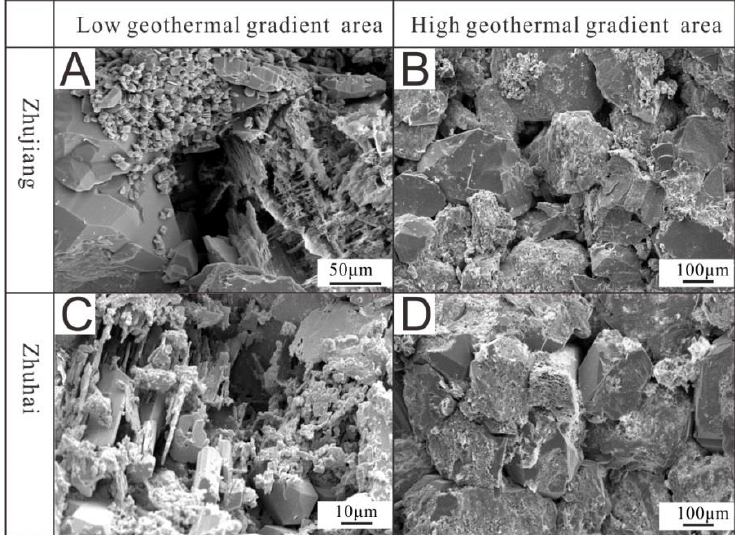
Figure 5. Typical SEM photomicrographs of sandstones in the Baiyun Sag. ( A ) Gra = 3.97 °C/100 m, quartz overgrowth and quartz crystal and authigenic kaolinite in intergranular pores. Secondary pores formed by the dissolution of potassium feldspar. ( B ) Gra = 4.54 °C/100 m, intergranular pore is the main type of pore. ( C ) Gra = 3.93 °C/100 m, the dissolution of feldspar increased the intergranular porosity. Authigenic quartz crystals grew in the pores. ( D ) Gra = 4.54 °C/100 m, intergranular pores are the main pore type.